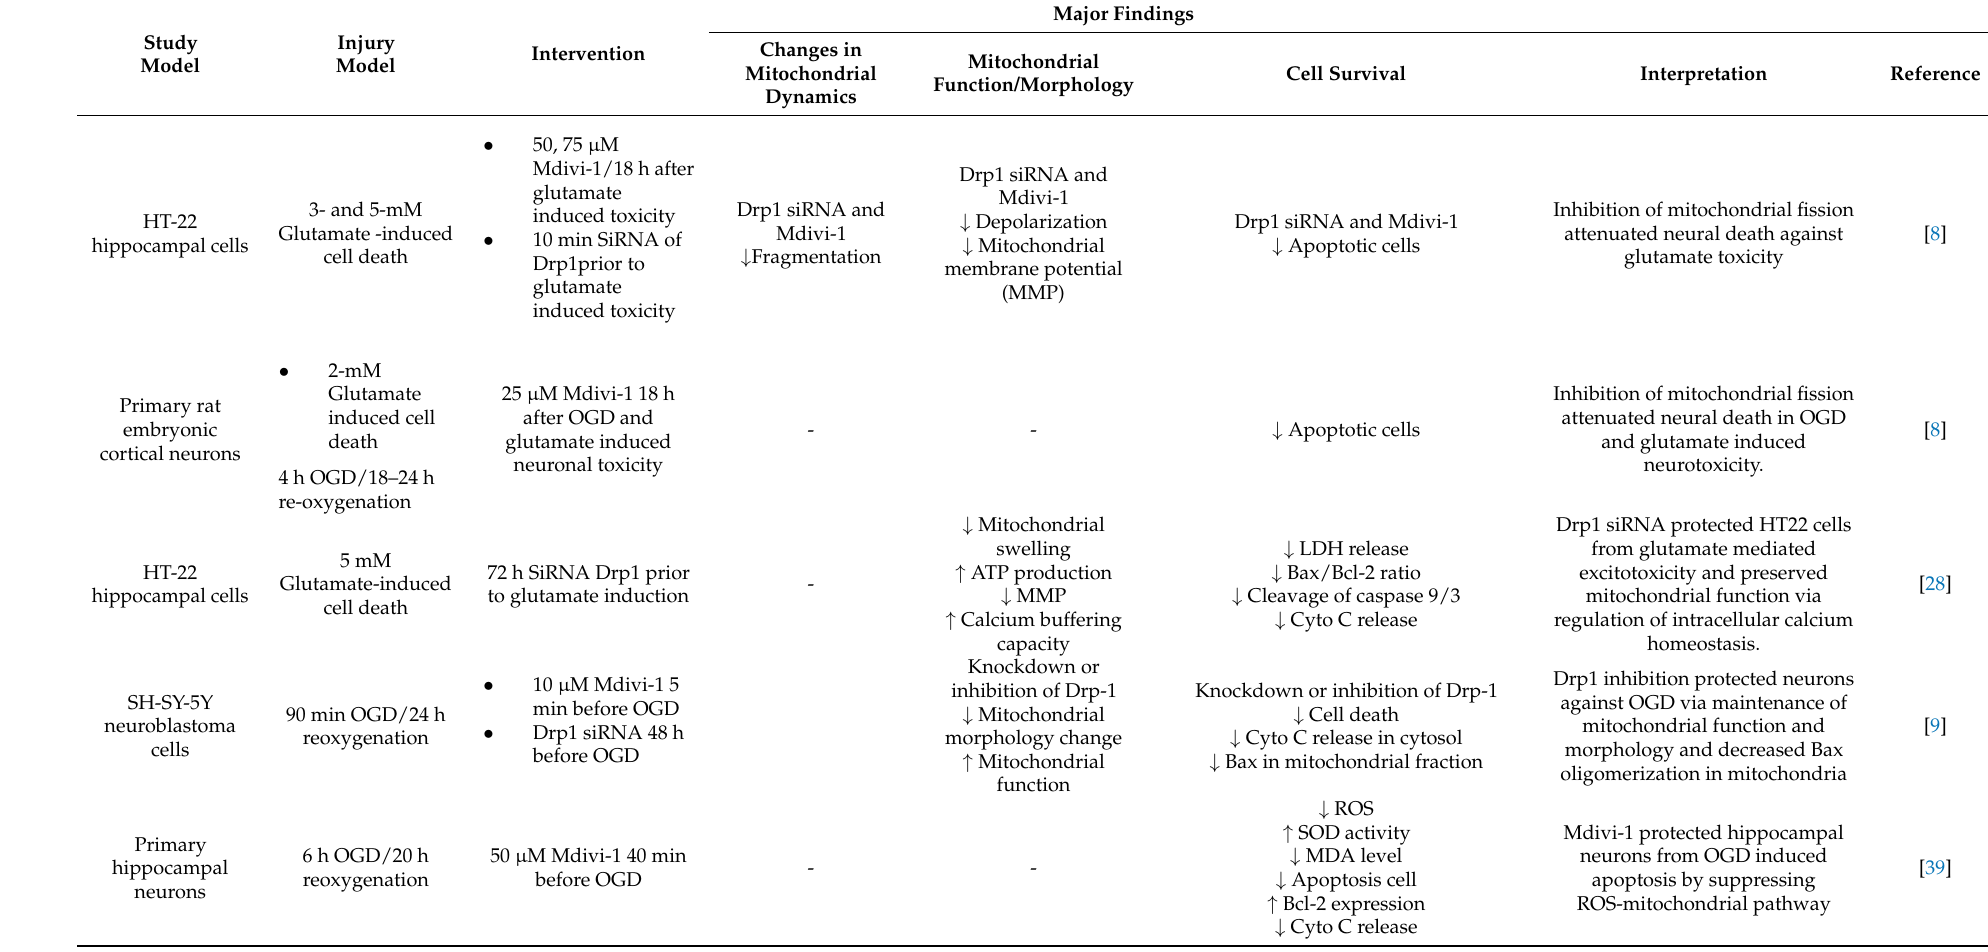
Table 3. Evidence in the interventions for the alterations in mitochondrial dynamics following oxygen-glucose deprivation/reoxygenation: in vitro